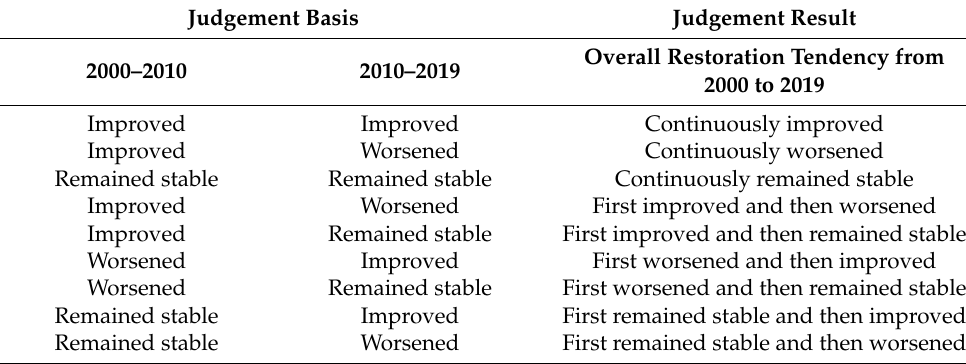
Table 2. Basis for judging the restoration tendencies of the ecosystem quality and ecosystem ser- vice parameters.